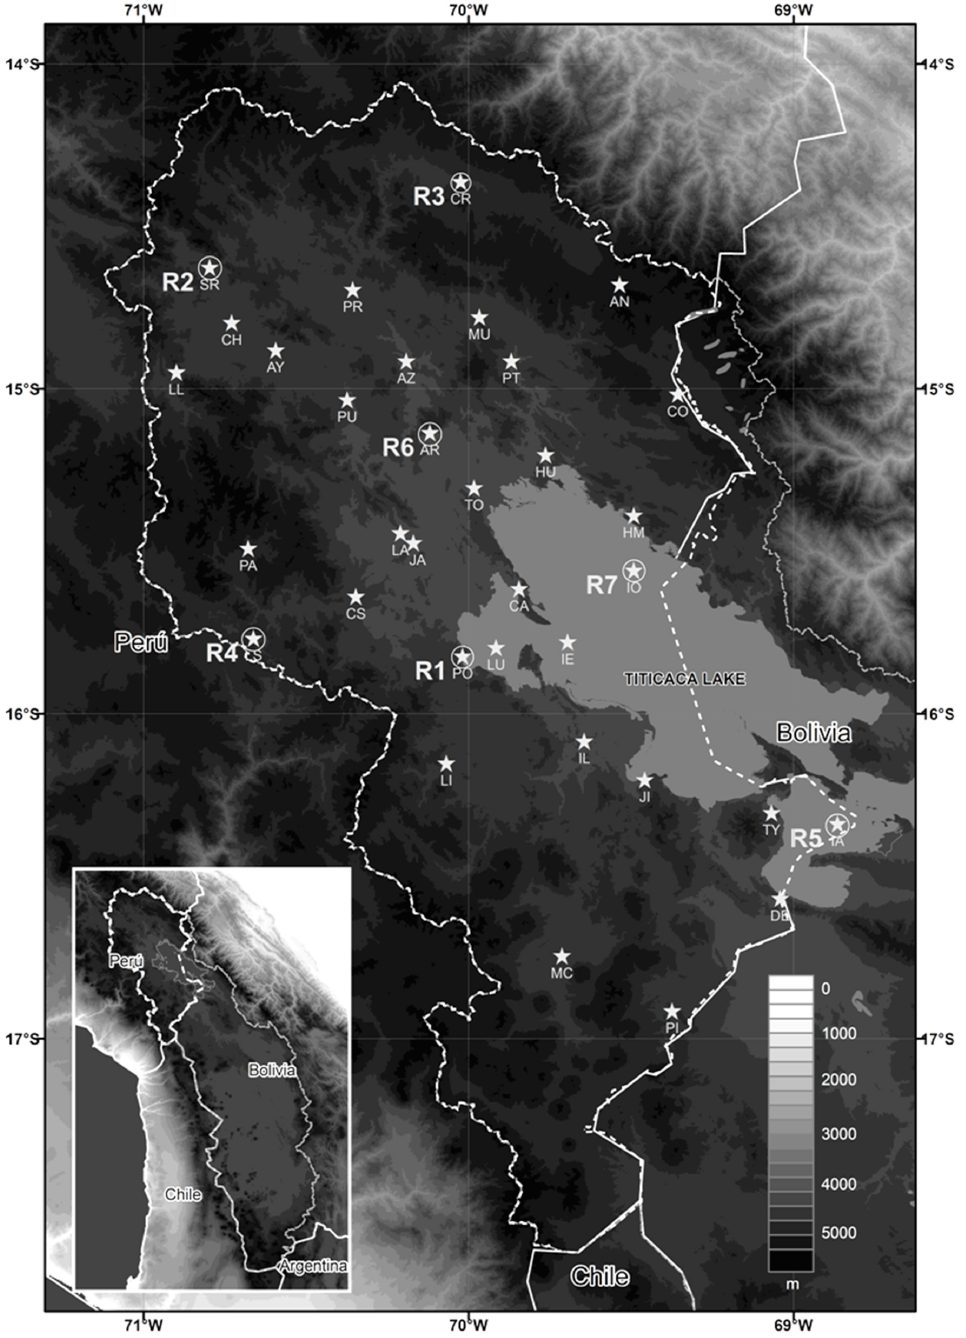
Figure 1. Study site of Lake Titicaca basin, Peru, showing the locations of rain gauge stations (represented by stars). The gray color scale represents elevation over the basin. The circles represent the subregions studied: Region 1—Puno (70 ◦ 01 (cid:48) 18 (cid:48)(cid:48) –69 ◦ 44 (cid:48) 55 (cid:48)(cid:48) W, 15 ◦ 58 (cid:48) 28 (cid:48)(cid:48) –15 ◦ 43 (cid:48) 13 (cid:48)(cid:48) S); Region 2—Santa Rosa (70 ◦ 53 (cid:48) 20 (cid:48)(cid:48) –70 ◦ 33 (cid:48) 54 (cid:48)(cid:48) W, 14 ◦ 39 (cid:48) 35 (cid:48)(cid:48) –14 ◦ 58 (cid:48) 15 (cid:48)(cid:48) S); Region 3—Crucero (70 ◦ 03 (cid:48) 47 (cid:48)(cid:48) – 69 ◦ 46 (cid:48) 15 (cid:48)(cid:48) W, 14 ◦ 31 (cid:48) 12 (cid:48)(cid:48) –14 ◦ 47 (cid:48) 35 (cid:48)(cid:48) S); Region 4—Cabanillas (70 ◦ 46 (cid:48) 05 (cid:48)(cid:48) –70 ◦ 27 (cid:48) 02 (cid:48)(cid:48) W, 15 ◦ 34 (cid:48) 51 (cid:48)(cid:48) – 15 ◦ 53 (cid:48) 31 (cid:48)(cid:48) S); Region 5—Isla Suana (68 ◦ 59 (cid:48) 27 (cid:48)(cid:48) –68 ◦ 39 (cid:48) 56 (cid:48)(cid:48) W, 16 ◦ 13 (cid:48) 59 (cid:48)(cid:48) –16 ◦ 33 (cid:48) 32 (cid:48)(cid:48) S); Region 6— Arapa (70 ◦ 12 (cid:48) 32 (cid:48)(cid:48) –69 ◦ 55 (cid:48) 16 (cid:48)(cid:48) W, 15 ◦ 05 (cid:48) 02 (cid:48)(cid:48) –15 ◦ 21 (cid:48) 56 (cid:48)(cid:48) S); Region 7—Isla Soto (68 ◦ 28 (cid:48) 43 (cid:48)(cid:48) –69 ◦ 10 (cid:48) 49 (cid:48)(cid:48) W, 15 ◦ 38 (cid:48) 39 (cid:48)(cid:48) –15 ◦ 55 (cid:48) 48 (cid:48)(cid:48)